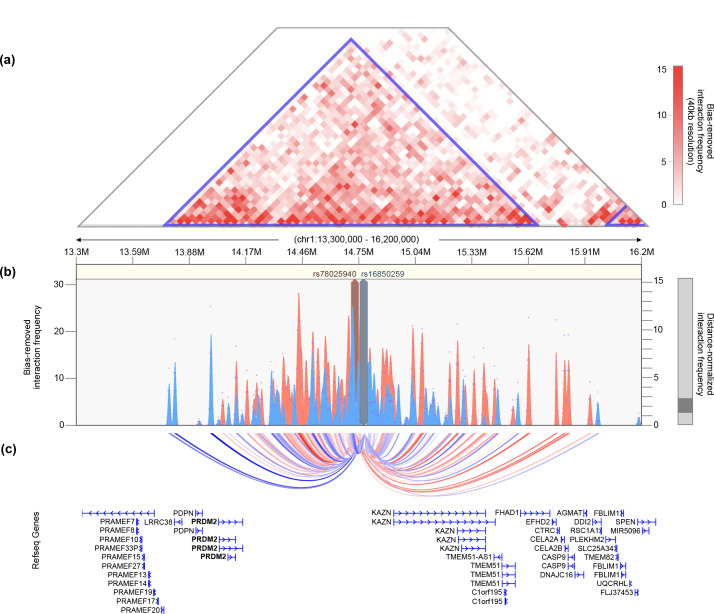
Chromatin interaction map of PRDM2/KAZN locus.(A) Shown is the interaction frequency heatmap from chr1:13,300,000–16,200,000 in ovarian tissue. The color of the heatmap indicates the level of normalized interaction frequencies with blue triangles indicating topological association domains. (B) One-to-all interaction plots are shown for the lead SNP (rs78025940; shown in red) and lead genotyped SNP (rs16850259; shown in blue) as bait. Y-axes on the left and the right measure bias-removed interaction frequency (red and blue bar graphs) and distance-normalized interaction frequency (magenta dots), respectively. (C) The arc representation of significant interactions for distance-normalized interaction frequencies ≥ 2 is displayed relative to the RefSeq-annotated genes in the locus. chr, chromosome; SNP, single nucleotide polymorphism.